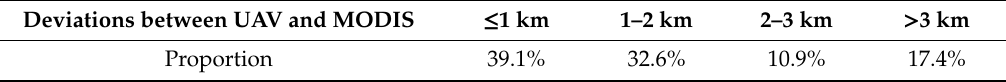
Table 1. Position deviations of fire spots monitored by UAV and MODIS.